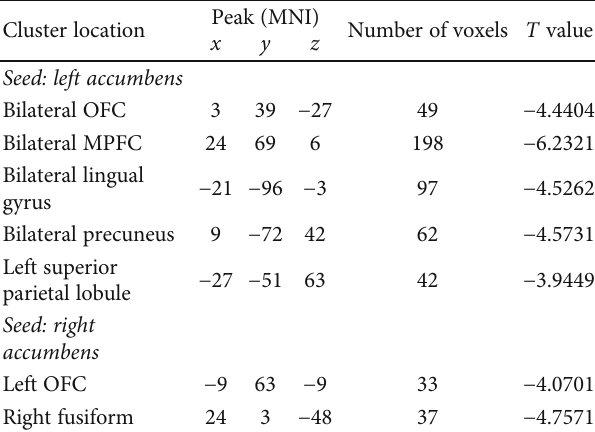
Table 2: Regions with abnormal functional connectivity with the accumbens in patients with